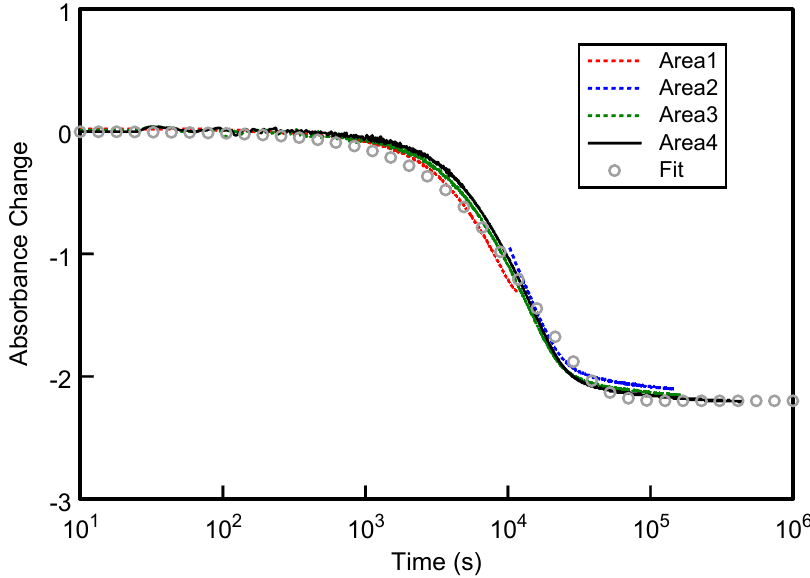
Figure 4. Absorbance kinetics recorded for the 2.5 μ m thick PE sample in Table 1 at different regions across the film surface. The open circles show the optimum fit to the composite data using Equation (3) and the parameters for the P(t) function in Equation (2) as described in the main text. Further absorbance data were recorded for the other MDP films listed in Table 1.